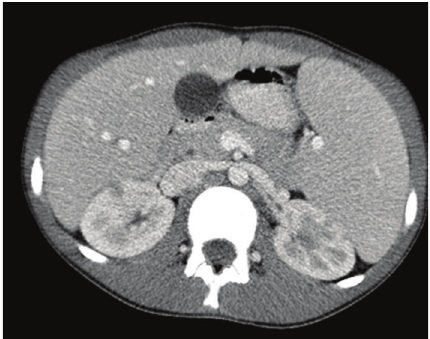
Figure 6: Axial contrast enhanced CT shows multiple, small, bilateral hypodense kidney lesions in keeping with lymphomatous involvement.